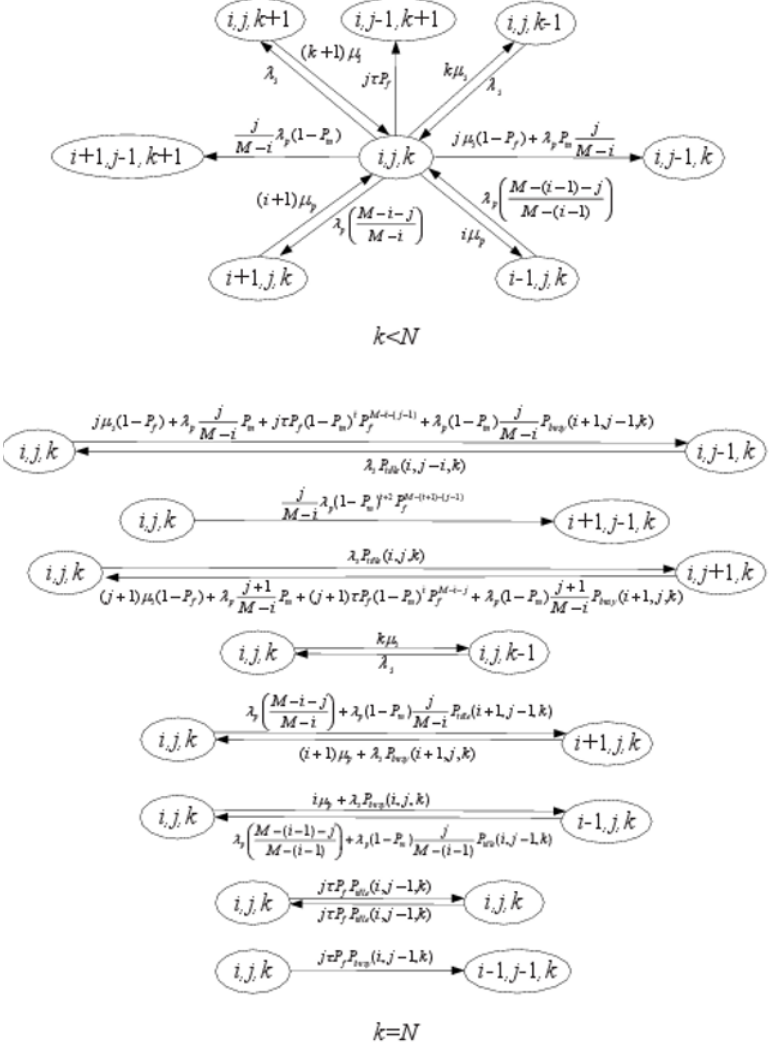
Figure 3. Rate diagram of state (i,j,k) in the OSA scheme with hopping under imperfect sensing. The UE services are dropped in the following cases. Firstly, the PU returns to the licensed PU channel and the UE sensed correctly, the UE service will be dropped due to all the channels are sensed as busy or the switching to the busy PU channel resulting from the miss detection event. Secondly, the PU returns to the licensed PU channel and the miss detection event happens, the UE dropped the channel due to the collision with the PU. Thirdly, the UE service is dropped due to the false alarm event and the